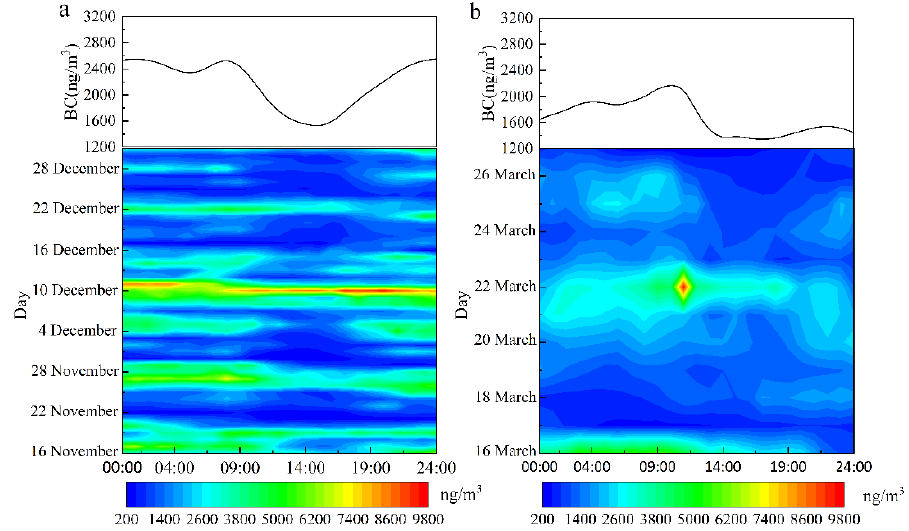
Figure 3. Monthly variation in BC concentration in the heating season and non-heating season (( a ): heating season; ( b ): non-heating season).